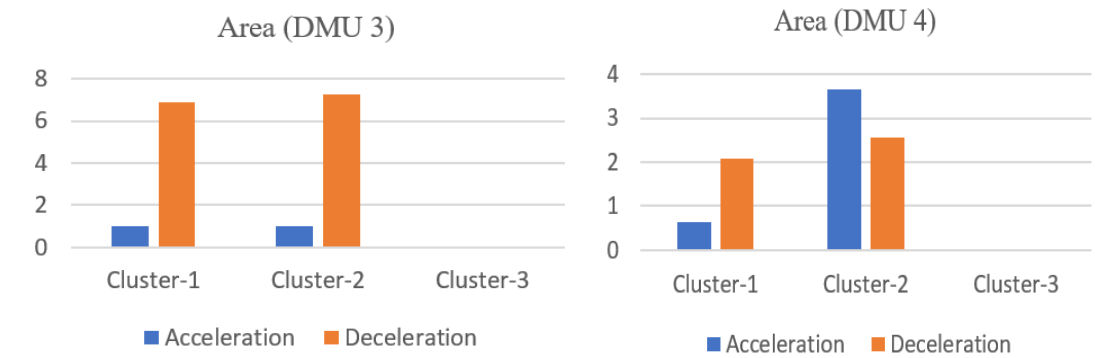
Figure 8. The area accumulation with respect to acceleration and deceleration for DMUs 3 and 4.